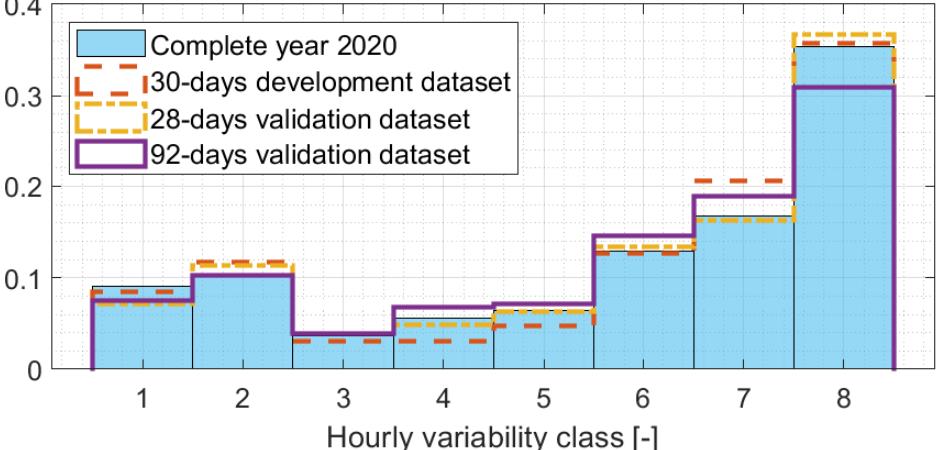
Figure 3. The distribution of the DNI variability classes, which are defined according to Nouri et al. [40], is shown for the whole year 2020 and for datasets of 30, 28 and 92 days cre- ated from that year. The 30-days development dataset is used for model development. The separate 92-days validation dataset is only used for validations. The 28-days validation dataset is a subset of the 92-days validation dataset and is also used for